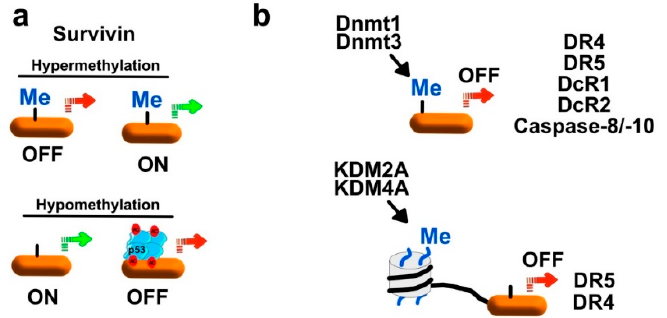
Figure 10. ( a ) Epigenetic regulation of survivin in transformed cells. The promoter region of